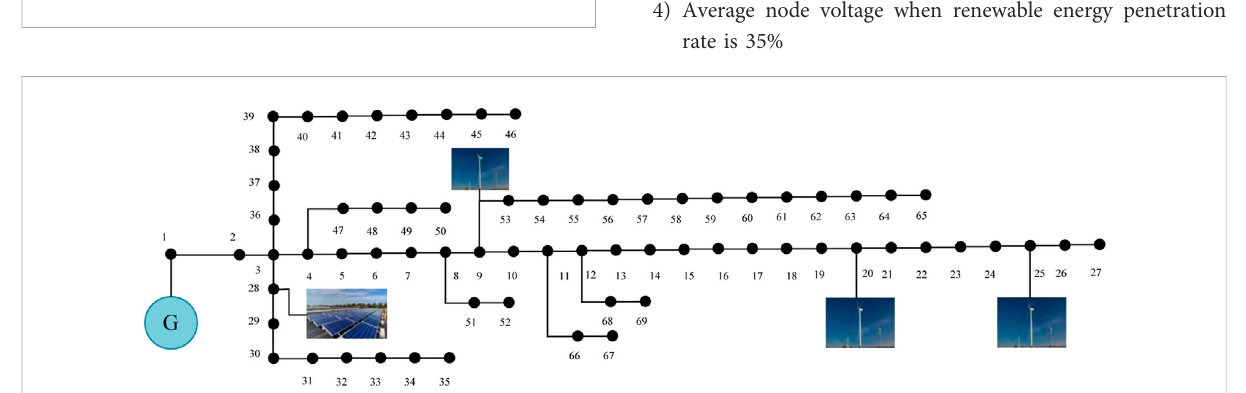
FIGURE 4 Average node voltage after optimized con fi guration of ESSs when renewable energy penetration is 20% and 35%. (A) Average node voltage when renewable energy penetration rate is 20 %; (B) Average node voltage when renewable energy penetration rate is 35 %.